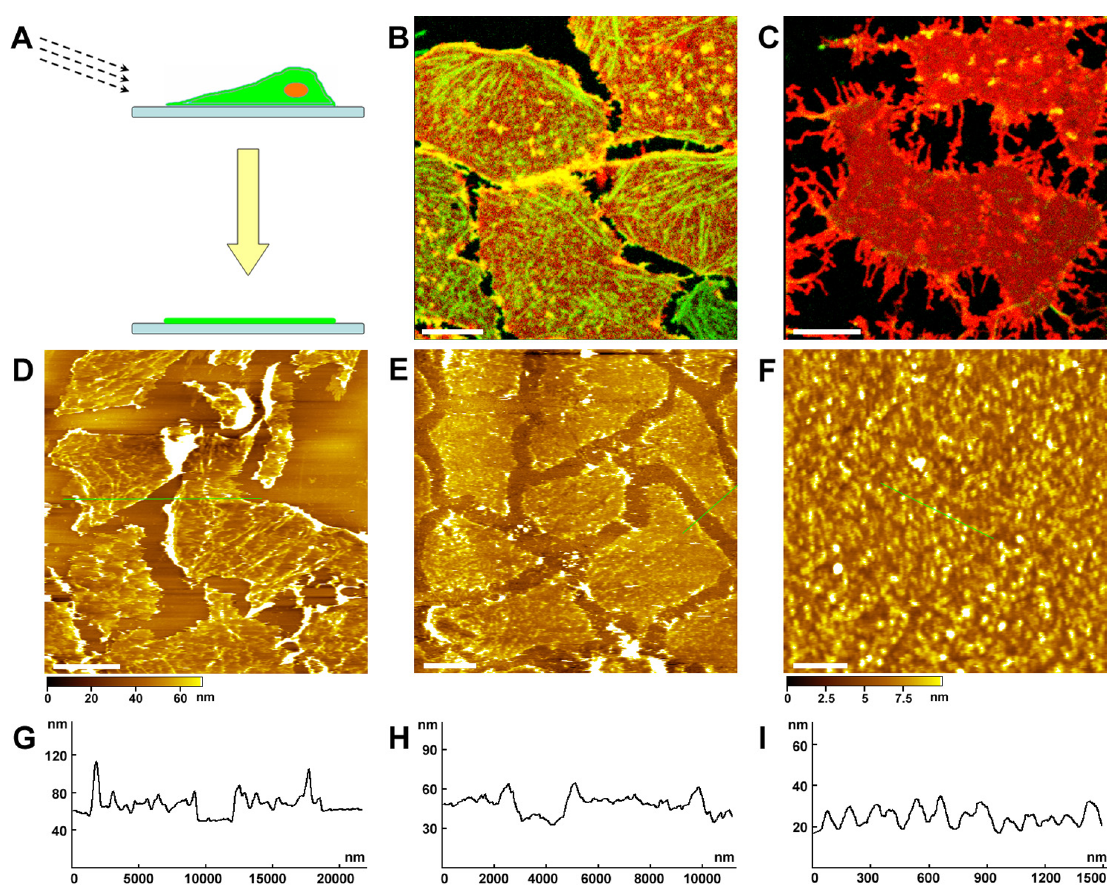
Figure 4. Imaging the cytoplasmic side of the cell membrane. (A) The scheme for preparing the cytoplasmic side of the cell membrane. (B and C) The fluorescent images of the cytoplasmic side of the cell membrane before and after incubation with high-salt buffer, respectively. The red membrane patches represent the lipid bilayer labeled with DiI, and the green fibers represent the actin filaments labeled with phalloidin-FITC. (D and E) The AFM topographic images of the cytoplasmic side of the cell membrane before and after incubation with high-salt buffer, respectively. (F) The high magnification image of the cytoplasmic side of the cell membrane. (G–I) Cross section analysis along the green line in (D–F), respectively. Scale bars: 7 m m in (B)–(E); 500 nm in (F). was 11.2 6 1.9 nm (Figure 4I). Based on the similarity of heights of the ectoplasmic protein layer and lipid bilayer both at about 4 nm (Figure 2), the total height of the cell membrane was calculated to be about 20 nm, consistent with the real size measured from the whole cell membrane (Figure 4E). The width of the protein microdomains was 98.5 6 8.6 nm, much larger than that of a single protein, about 20 nm measured by AFM [39], indicating the presence of multiple proteins in the microdomains. The distribu- tion of distances of the adjacent protein domains from border to border was about 53.2 6 12.0 nm. These results demonstrate that the cytoplasmic side consists of protein microdomains scattered in the lipid bilayer.